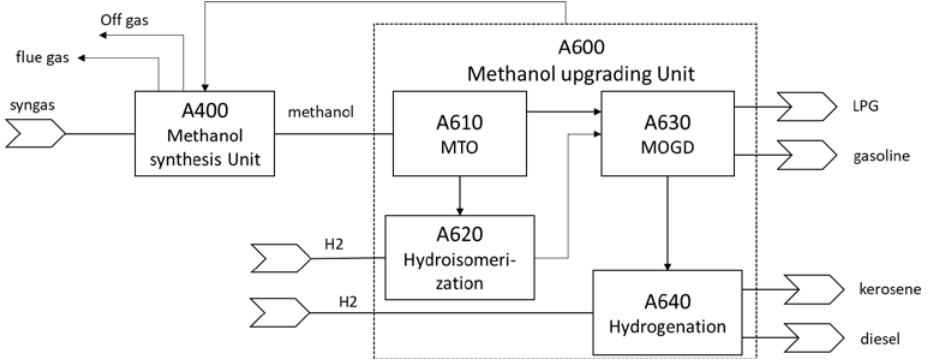
Figure 7. Block flow diagram of the methanol-to-transportation fuel process.